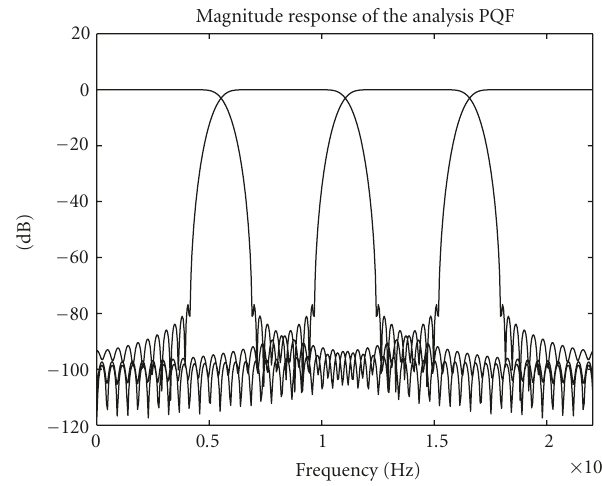
Figure 8: Magnitude frequency response of the analysis filterbank.